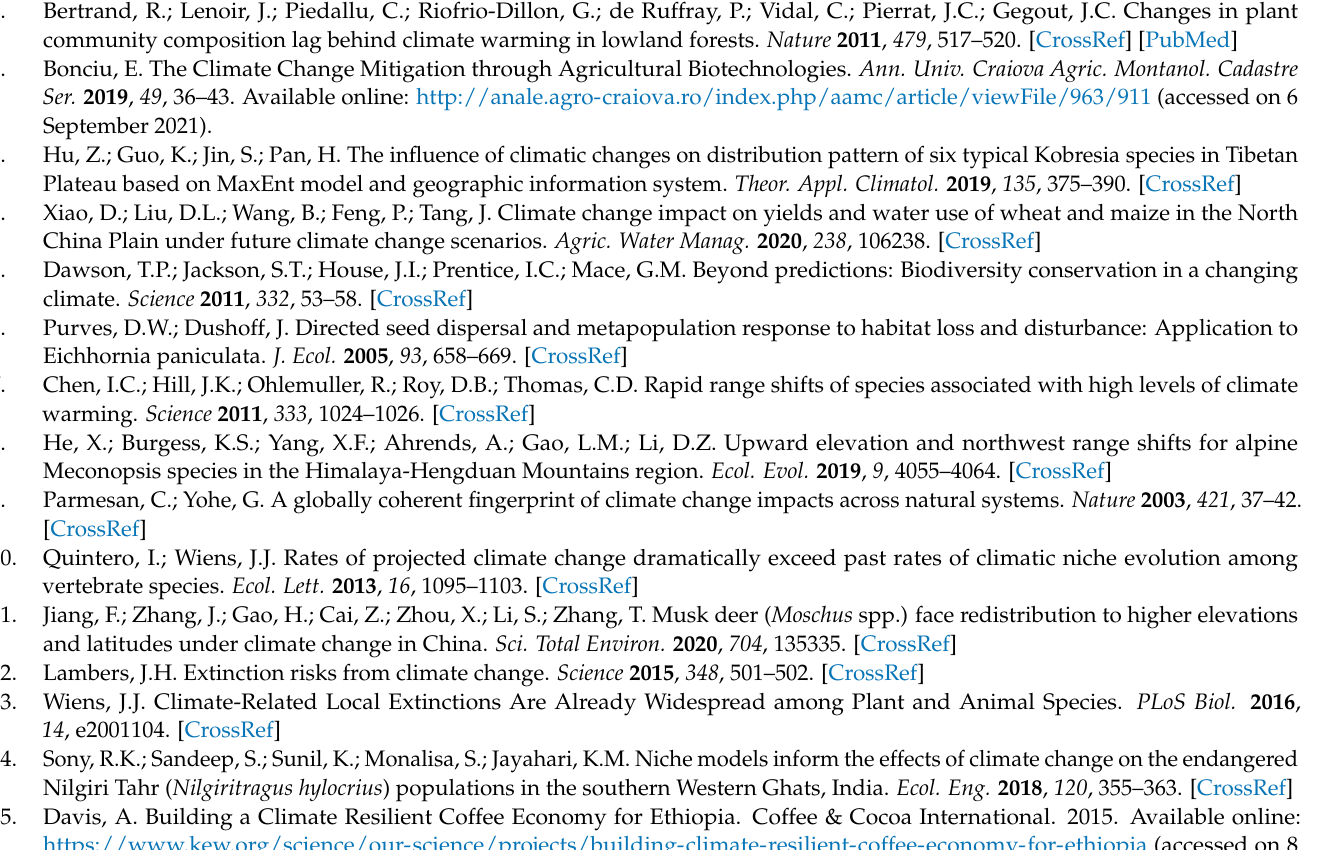
Figure S2: The results of the jackknife test of variables’ contribution in modelling Pomatosace filicula distribution in the current situation; Table S2 Comparison between the current distribution and the suitable areas of P. pinnatifida in 2050 and 2070 under four climate scenarios; Figure S3: Response curves of 10 environmental variables in habitat distribution model of Pomatosace filicula ; Table S3: Precipitation of 24 observation points in the middle and high suitable area and low suitable area of the Qinghai Tibet Plateau from 1952 to 2016; Figure S4: In the current situation, MaxEnt model is used to analyze the receiver operating characteristic (ROC) curve and average test AUC of Pomatosace filicula ; Figure S5: The results of the jackknife test of variables’ contribution in modelling Pomatosace filicula distribution in 2050 and 2070 under four climate scenarios and five general circulation